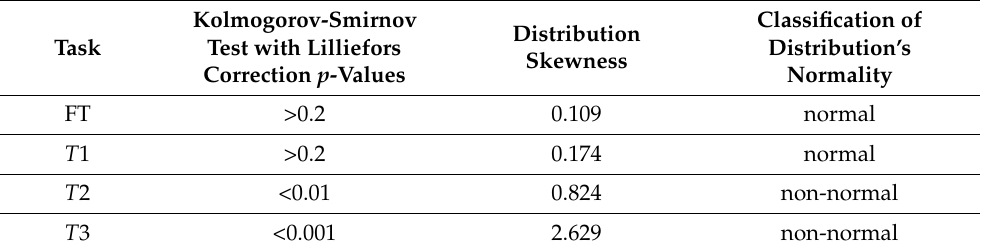
Table 1. Compliance with the normal distribution and the level of skewness in sets of RT-data in four consecutive tasks. Kolmogorov-Smirnov Classification of Distribution Task Test with Lilliefors Distribution’s Skewness Correction p -Values Normality FT >0.2 0.109 normal T 1 >0.2 0.174 normal T 2 <0.01 0.824 non-normal T 3 <0.001 2.629